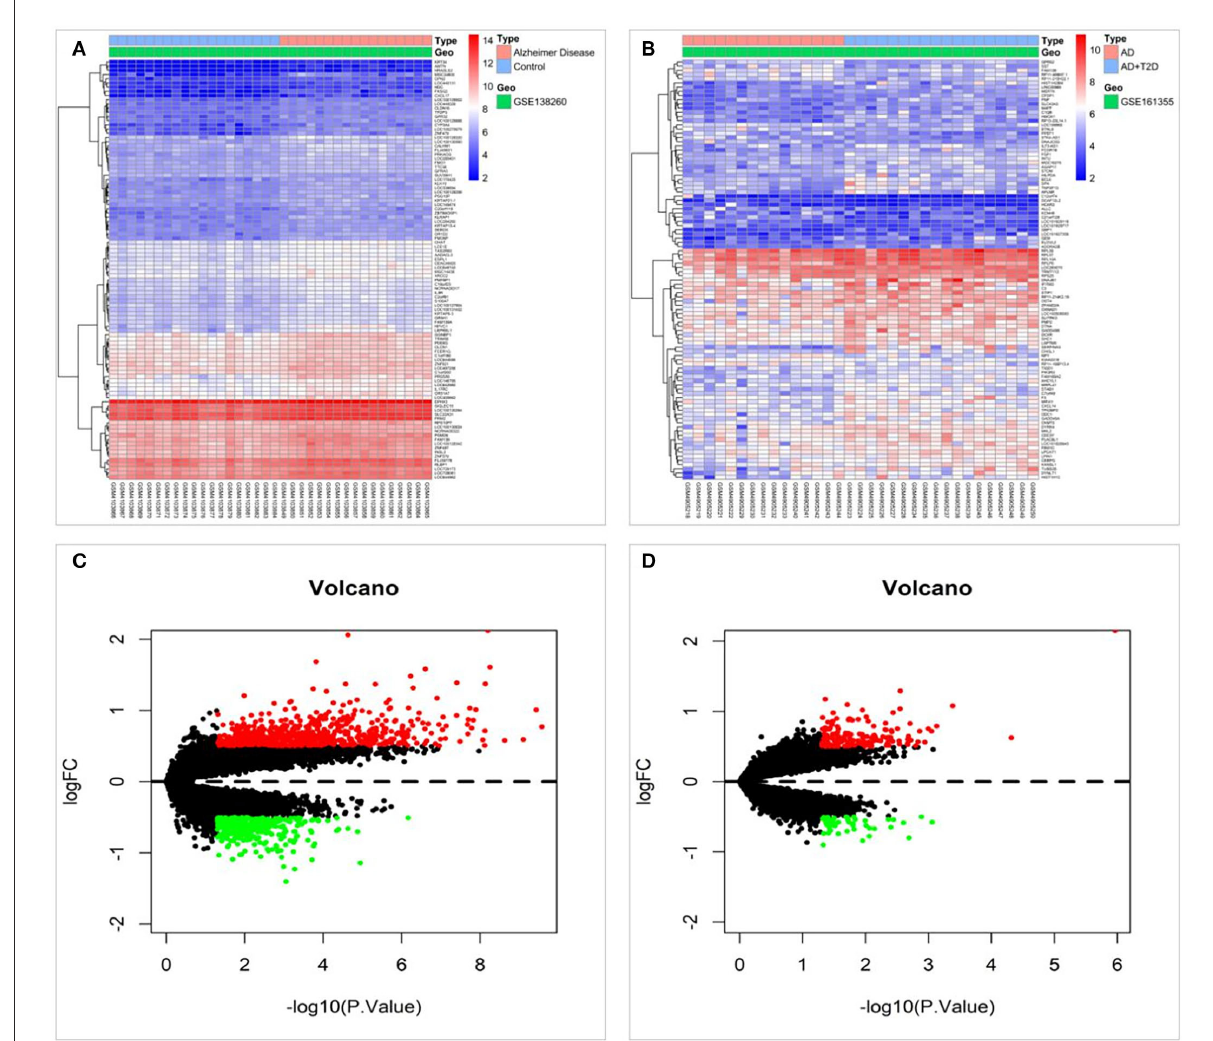
FIGURE2 Differentially expressed mRNAs were screened in the GSE138260 and GSE161355 datasets. (A) Heat map of differentially expressed genes in the GSE138260 dataset. (B) Heat map of differentially expressed genes in the GSE161355 dataset. (C) Volcano plot of differentially expressed genes in the GSE138260 dataset. (D) Volcano plot of differentially expressed genes in the GSE161355